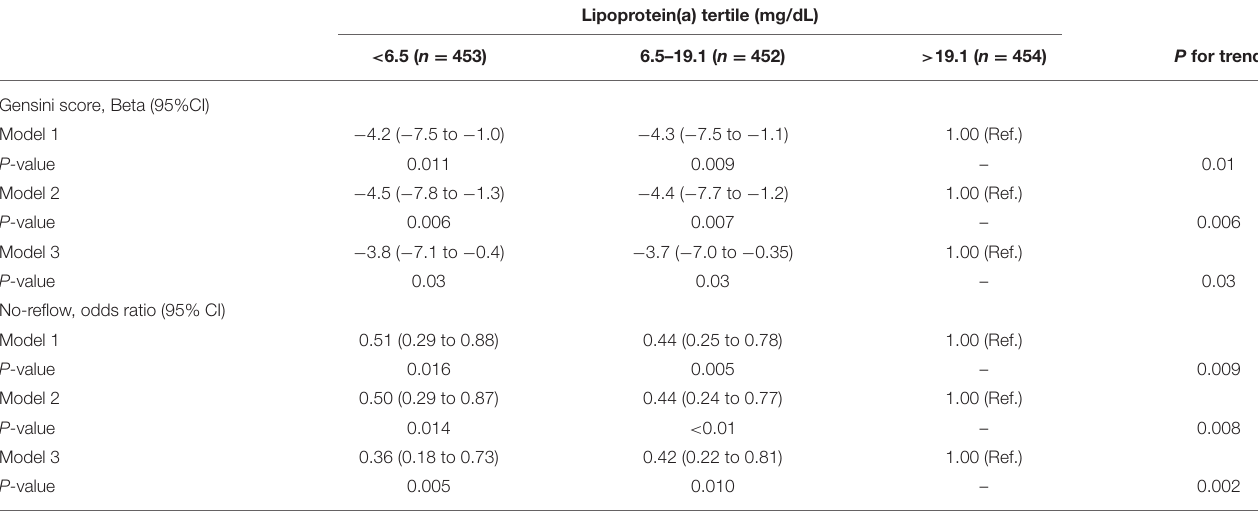
TABLE 3 | Multivariate analysis of the association between lipoprotein(a) and Gensini scores or no-reflow phenomenon.